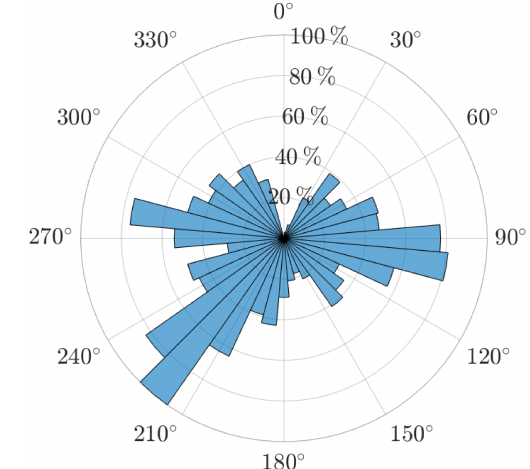
Figure 2. Availability of data per wind direction interval nor- malised to the number of the available correlation intervals for 220 ◦ , namely 9102133 intervals. The outer labels depict the wind direc- tion, and the inner circles denote the percentage of